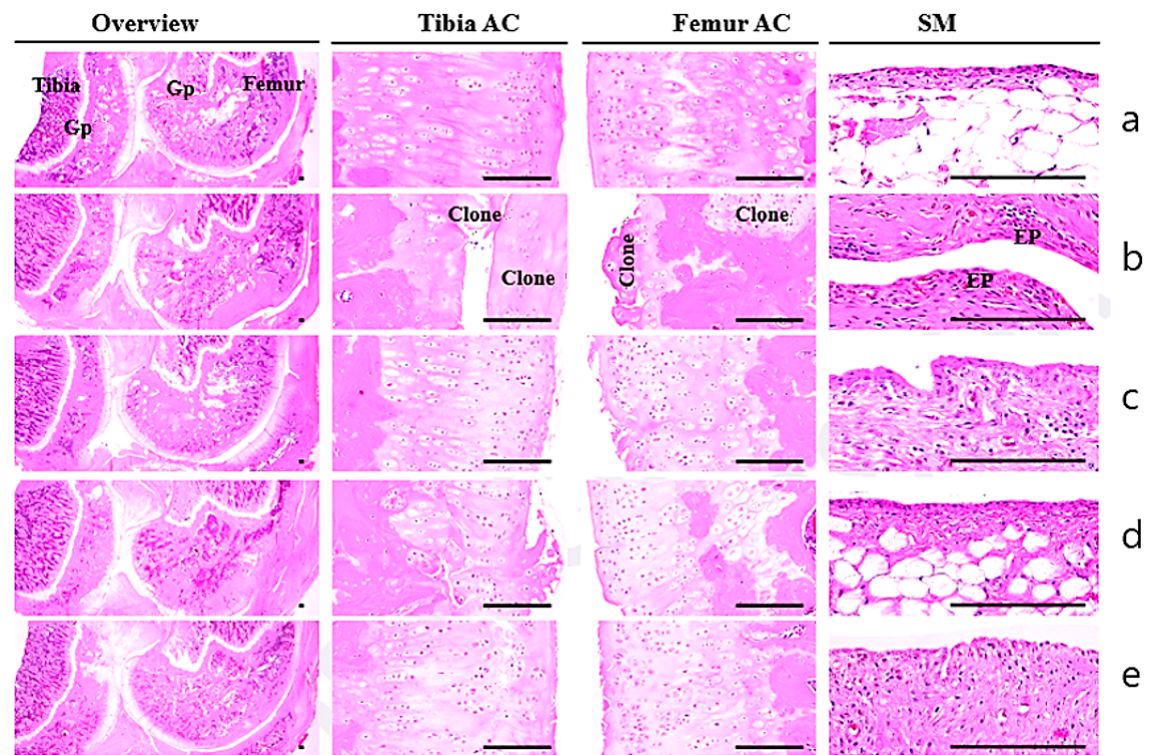
Figure 2. The effects of PS on H&E-stained histopathological profiles of knee joint tissues in rats with surgically induced OA (40X). ( a ) CON: normal sham control; ( b ) NC: negative control; ( c ) PC: positive control, rats treated with diclofenac sodium salt at 2 mg/kg BW in sterilized saline into the dorsal skin; ( d ) PS1: PS at 100 mg/kg BW; ( e ) PS2: PS at 300 mg/kg BW. Gp: growth plate; EP: epithelium; scale bars = 160 µ m. Table 5. The effects of PS on histomorphometrical values of the articular surface lining cartilage and synovial membrane of the knee joint tissues in the OA